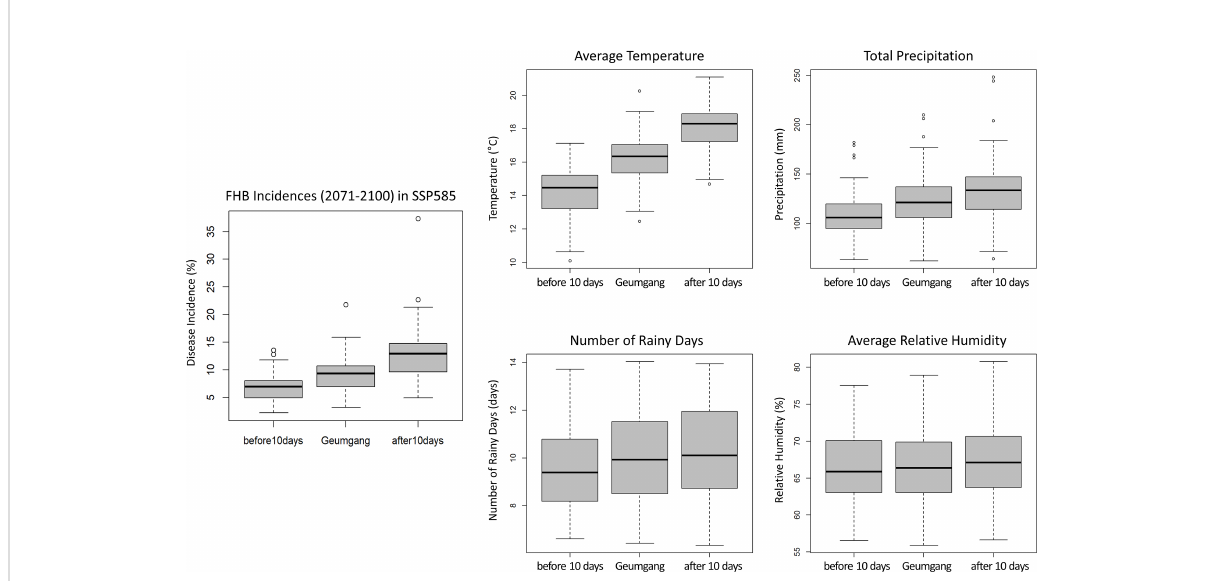
FIGURE 4 Comparisons of the adaptation strategy using early (before 10 days) or late (after 10 days) heading dates for the projected FHB incidences and the corresponding weather conditions of average air temperature, total precipitation, number of rainy days, and average relative humidity during the duration of GIBSIM simulations. Box plots were made with the results from multiple wheat-suitable areas based on the SSP585 scenario for the distant future period